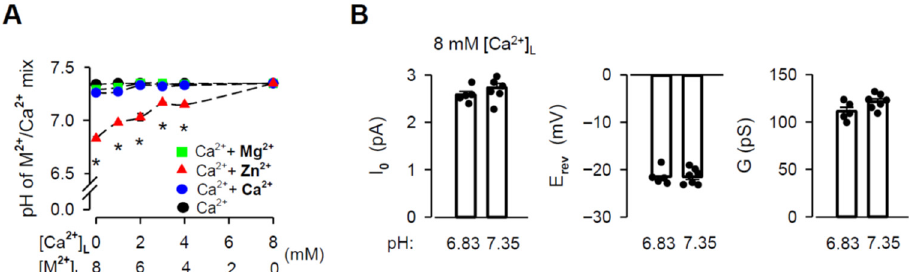
Figure 4. Changes in pH caused by the Zn 2+ additions have no effects on RYR2 permeation properties. ( A ) Effects of the M 2+ additions on pH of M 2+ /Ca 2+ mixture (M 2+ : Mg 2+ − green square, Zn 2+ –red triangle, or Ca 2+ –blue circle). In total, 4–7 mM [M 2+ ] L was added to 1–4 mM [Ca 2+ ] L , keeping the total divalent concentration constant at 8 mM. As the control, the [Ca 2+ ] L -dependence of pH is shown (black circle). Data obtained for the pure 8 mM [M 2+ ] L (chloride salt) or 8 mM [Ca 2+ ] L (hydroxide) are also included. * Significantly different from the respective control values (one-way ANOVA with Tukey’s post hoc test). ( B ) The I 0 , E rev and G values obtained for pH of 6.83 and 7.35 when 8 mM [Ca 2+ ] L (hydroxide) was present (unpaired Student’s t test). Data shown are average ± SEM of 5–7 experiments, and error bars in ( A ) are shown only when SEM is larger than symbol size. Data points shown in ( B ) are individual measurements.